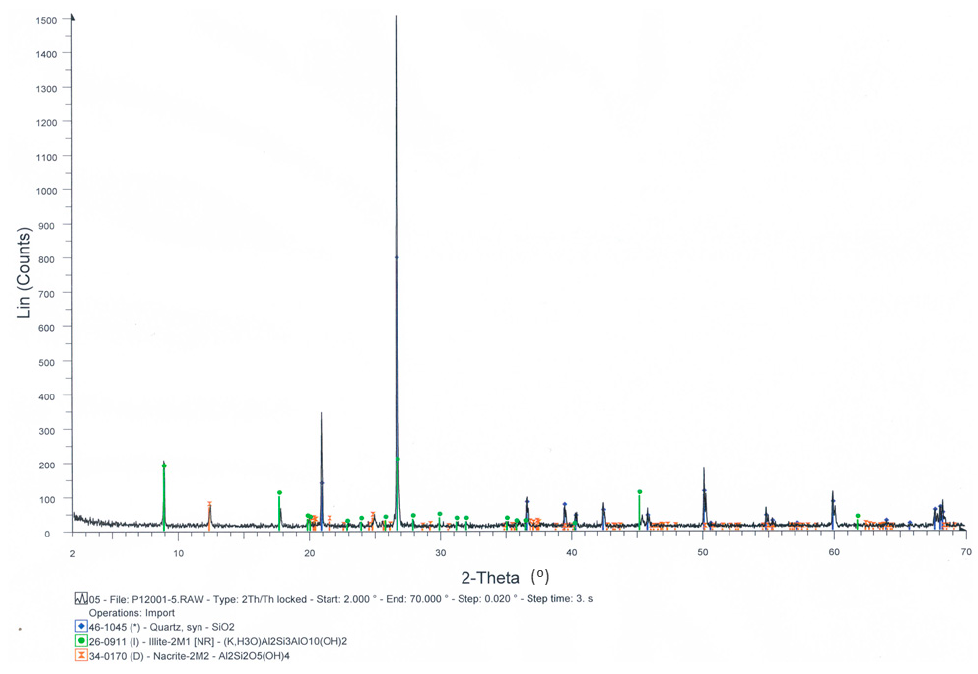
Figure 1. Mineralogical analysis result.